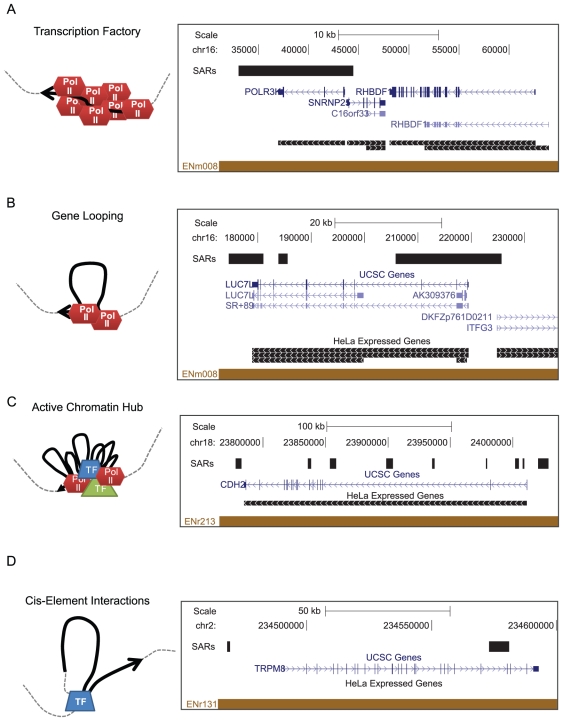
SARs may represent a variety of transcriptionally-mediated genomic interactions.UCSC Genome Browser images of representative loci containing SARs that may correspond to A.) a transcription factory, B.) gene looping, C.) an active chromatin hub, and D.) transcription factor-mediated cis-element interaction.